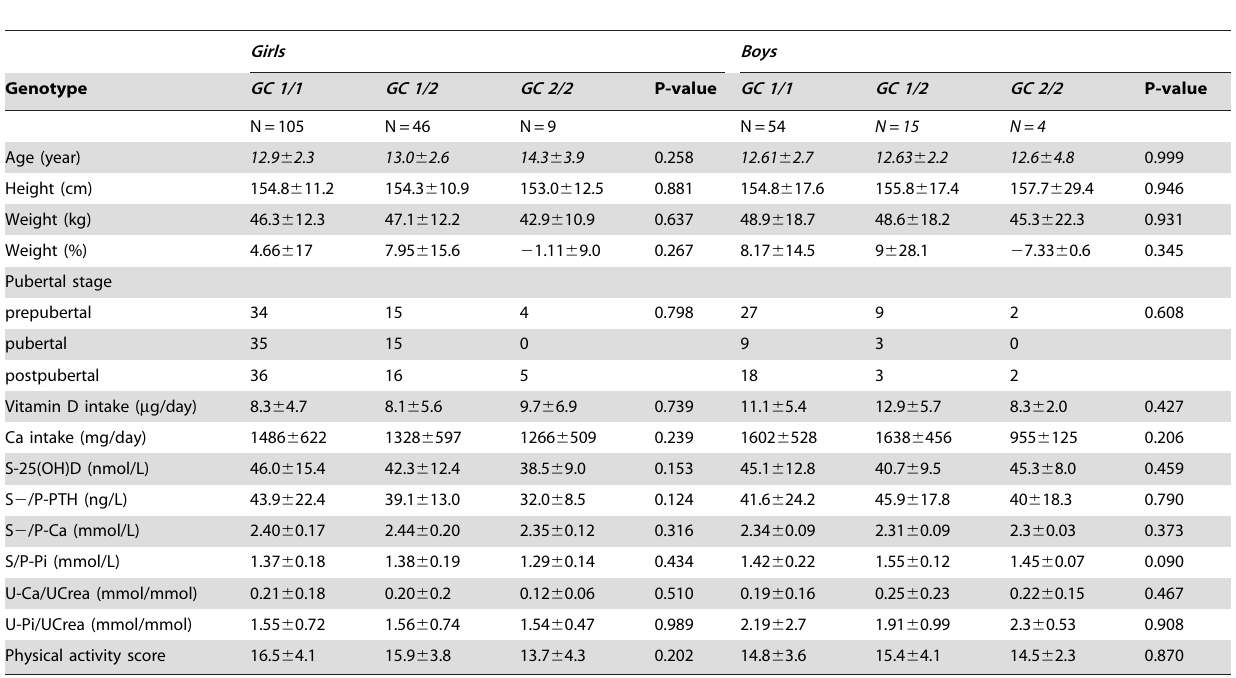
Table 1. Baseline characteristics by sex and Gc genotype the comparison are made by ANOVA without covariates.